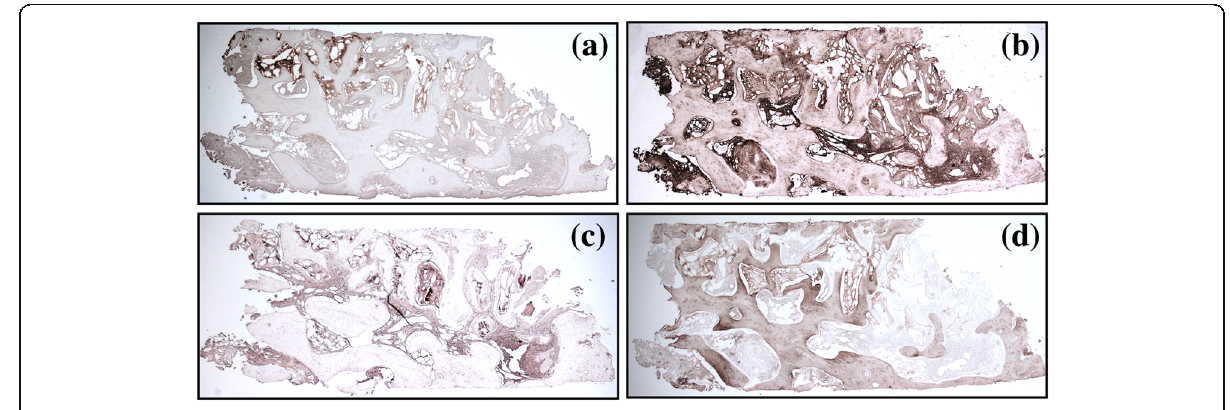
Fig. 6 Immunohistochemical analysis of slices from the same sample with four different markers. a TRAP. b OPN. c ALP. d